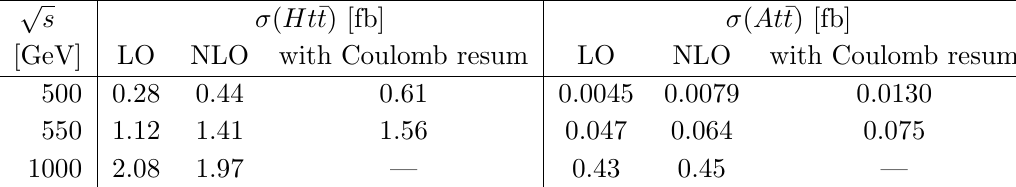
Table 2 . e + e (cid:0) ht (cid:22) t cross sections at LO, NLO and with Coulomb-resummation corrections !